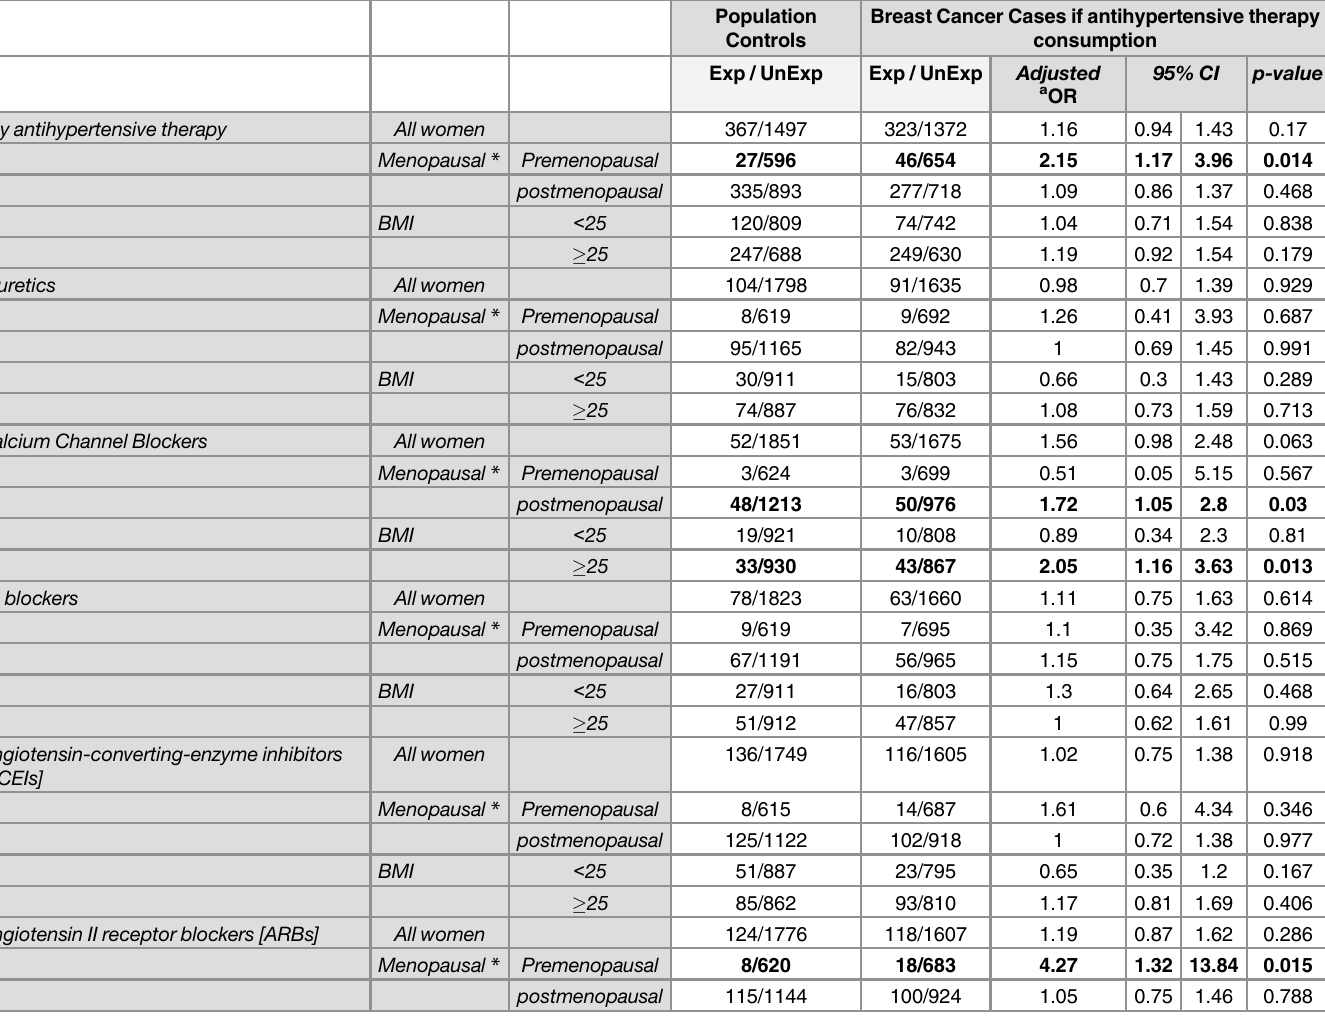
Abbreviations: CI, Con fi dence interval; OR, odds ratio